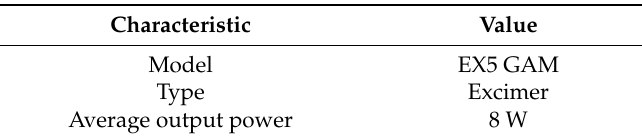
Table 1. KrF excimer laser